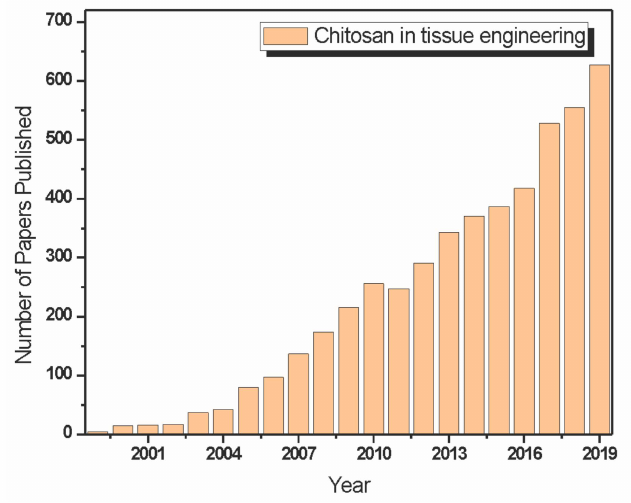
Figure 3. Literature data extracted from the Web of Science Core Collection about papers that address chitosan (CS) applied in the field of tissue